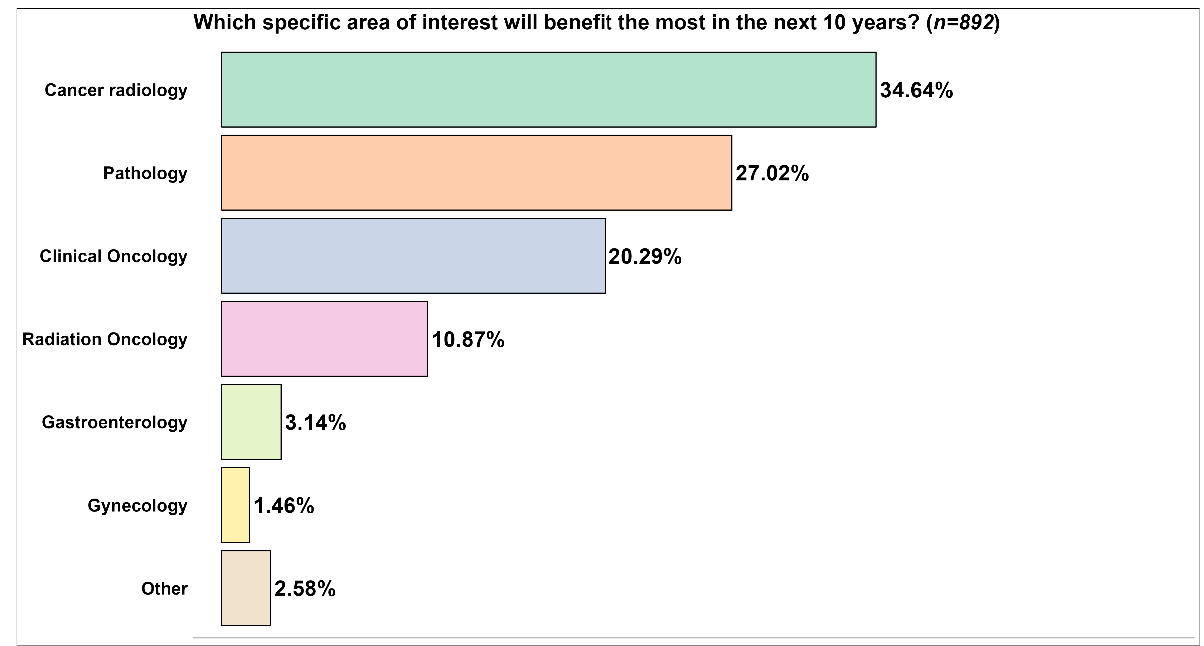
Figure 4. Areas of interest most likely to bene fi t from AI in the next ten years.